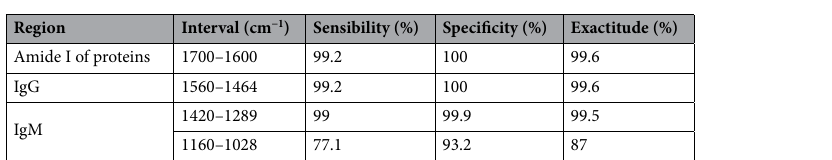
Table 5. Sensibility, specify, and exactitude of the multiple linear regression model (MLRM).